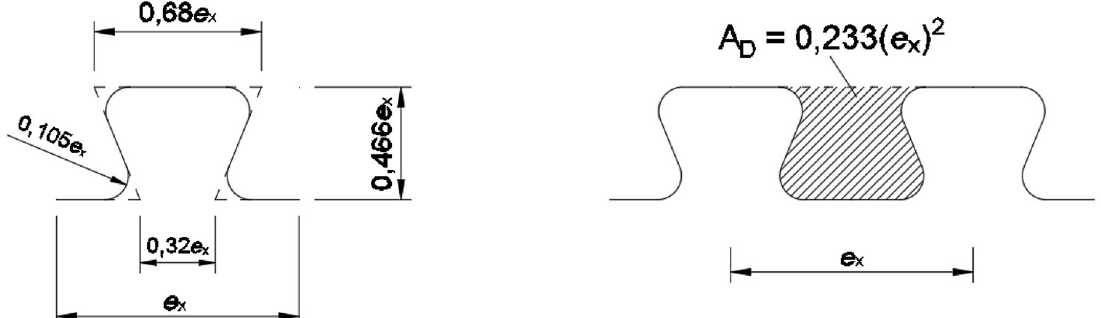
Figure 19. Crestbond dimensions as a function of dowel spacing e x